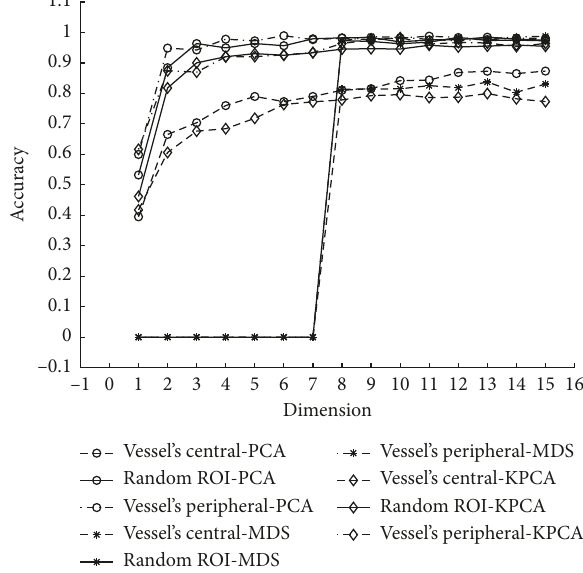
Figure 10: Spectral classification comparisons with BP neural network classifier.